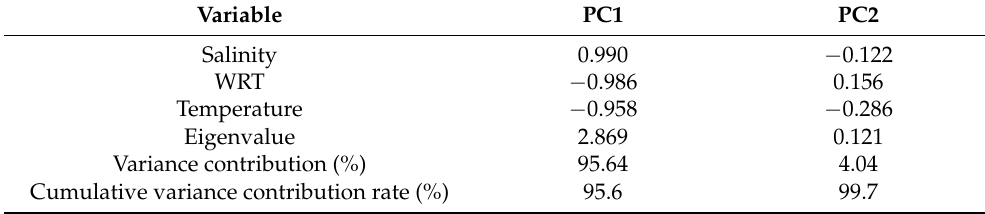
Table 3. Eigenvalues, the proportion of total variability, as well as correlations between the original variables and the first three principal components (PCs).